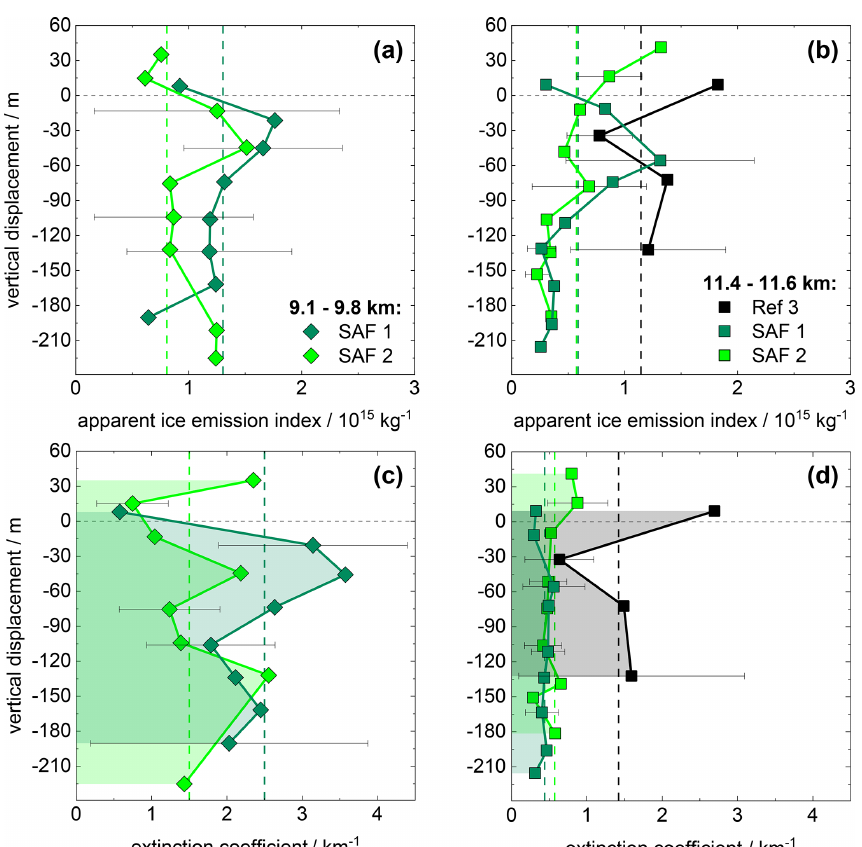
Figure 3. Profiles of mean AEI (a, b) and mean extinction coefficients (c, d) in 30m sections (60m for Ref 3). The A320 flight level is depicted by the grey horizontal reference line at 0m. Dashed vertical lines show overall means. Error bars show a selection of standard deviations of the single-plume encounters in 30m sections (60m for Ref 3). The shaded areas in panels (c) and (d) show the calculation of the contrail optical depths by integration of the extinction coefficients. (a, c) 9.1–9.8km (diamonds). (b, d) 11.4–11.6km (squares).